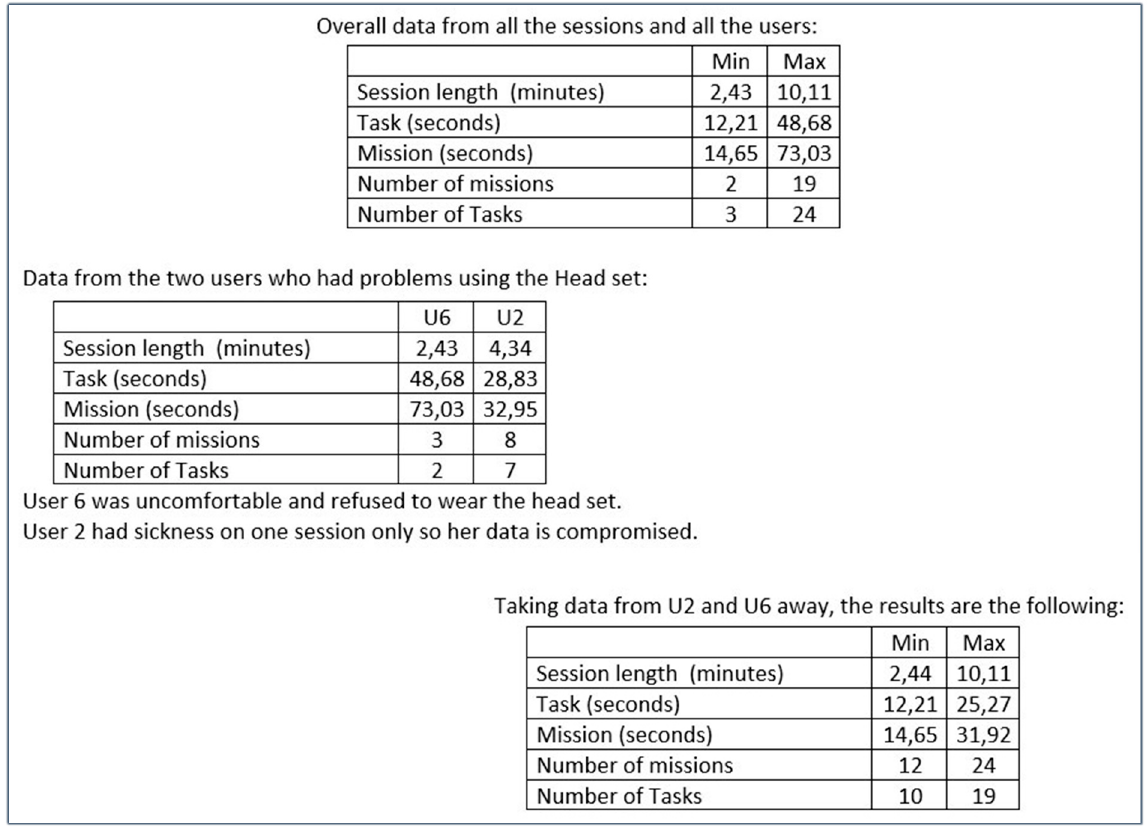
Figure 3. Data from the first tests of the Serious